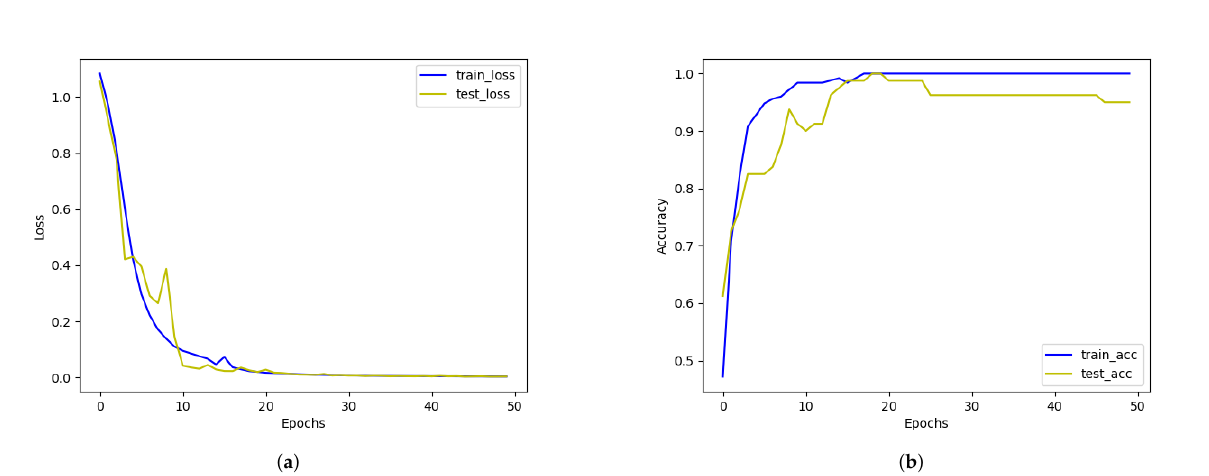
Figure 13. Process of model training. ( a ) Loss curve, ( b ) Accuracy curve.